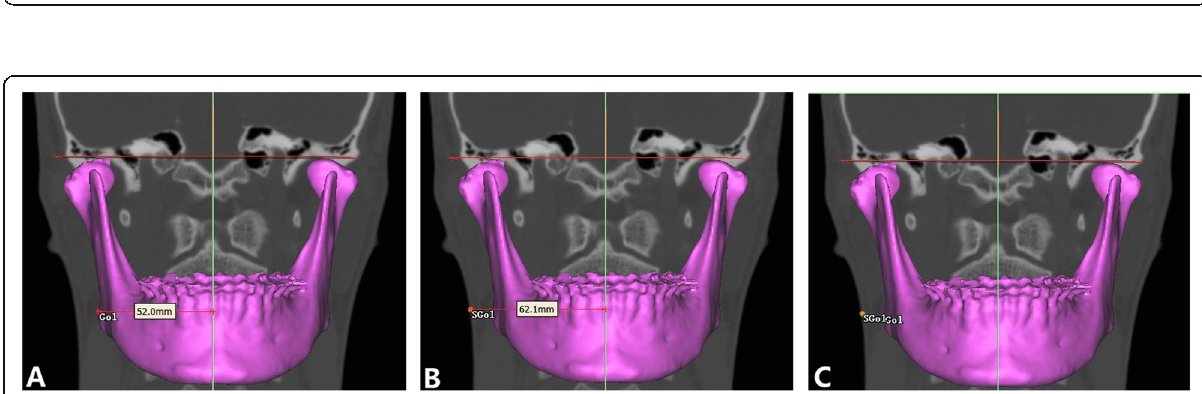
Fig. 1 The 3D position of the points used in this study. A Axial slice with points Go1, Go2, and Go3; B coronal slice with points Go1, Go4, and Go6; C lateral view of 3D reconstruction illustrating the position of the reference points used to measure hard tissue and soft tissue asymmetry and soft tissue thickness on the right side